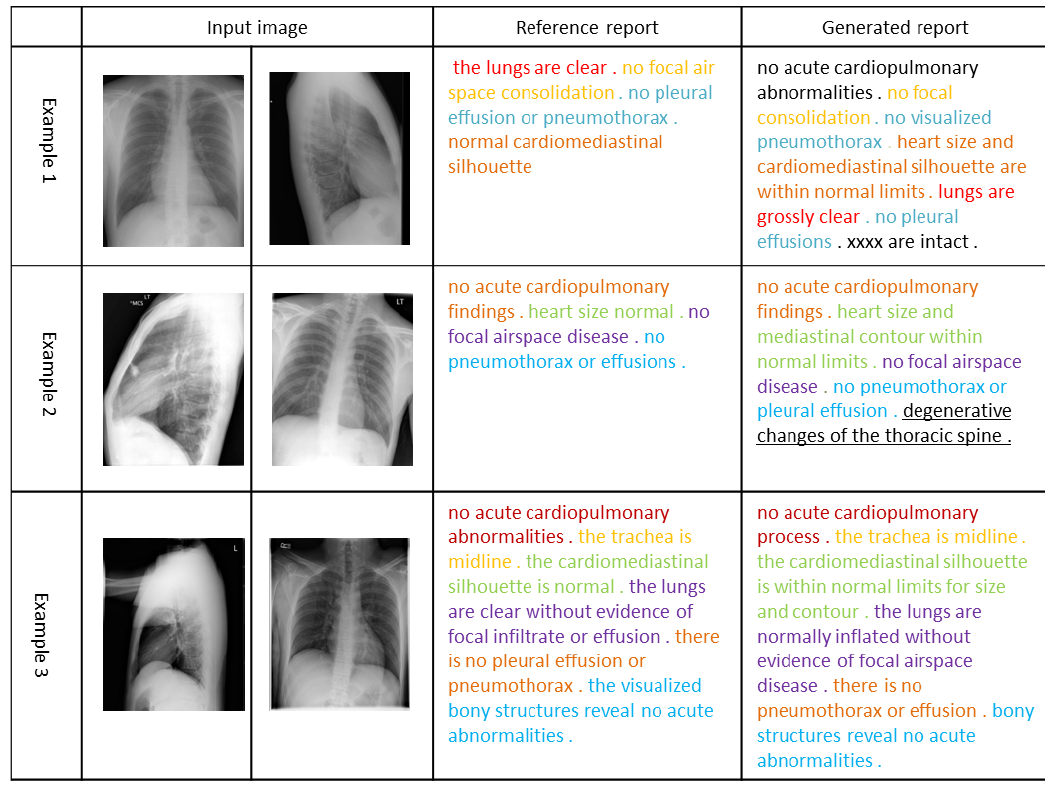
Figure 3. Examples of three visual reports selected from the Open-I dataset. The same color emphasizes the same description of the chest X-ray image. Additional findings of our model for images are highlighted by underlines.